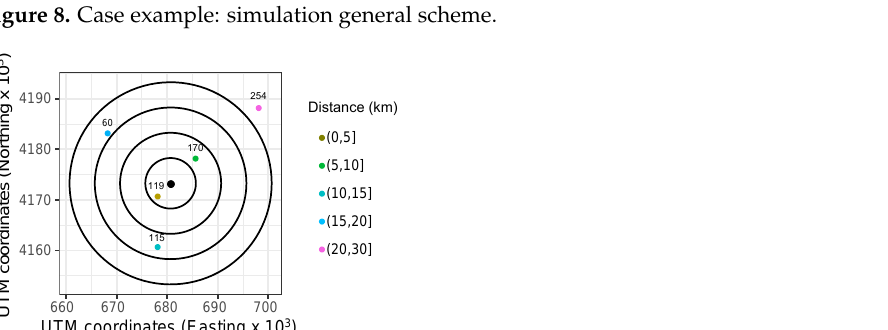
Figure 8. Case example: simulation general scheme.